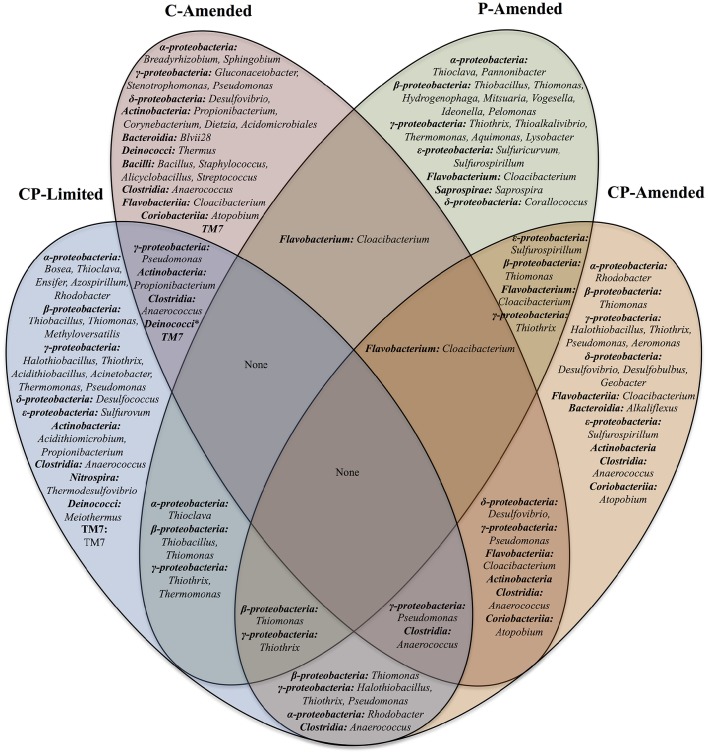
Venn diagram of the shared bacterial genera found in the four reactor treatments (CP-Limited, P-Amended, C-Amended, CP-Amended). Community membership overlaps between the reactors are indicated by overlaps in the diagram.